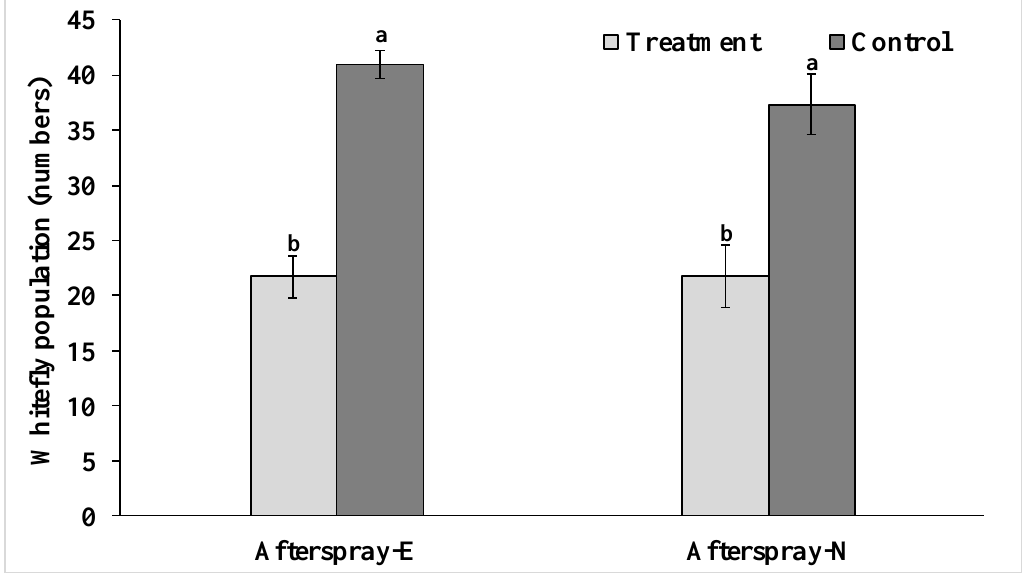
Figure 5. Field evaluation of S. lanosoniveum on the egg and nymphal population of RSW at 14 days after treatment (DAT). The different letters in Afterspray-E and Afterspray-N indicate differences between treatments. E—egg populations; N—nymphal populations.